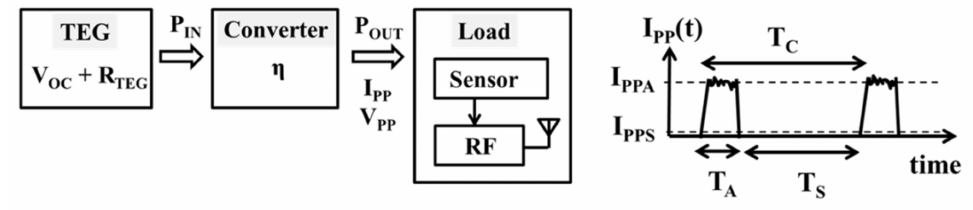
Figure 1. Block diagram of an energy harvesting system with TEG, converter, sensor and RF.